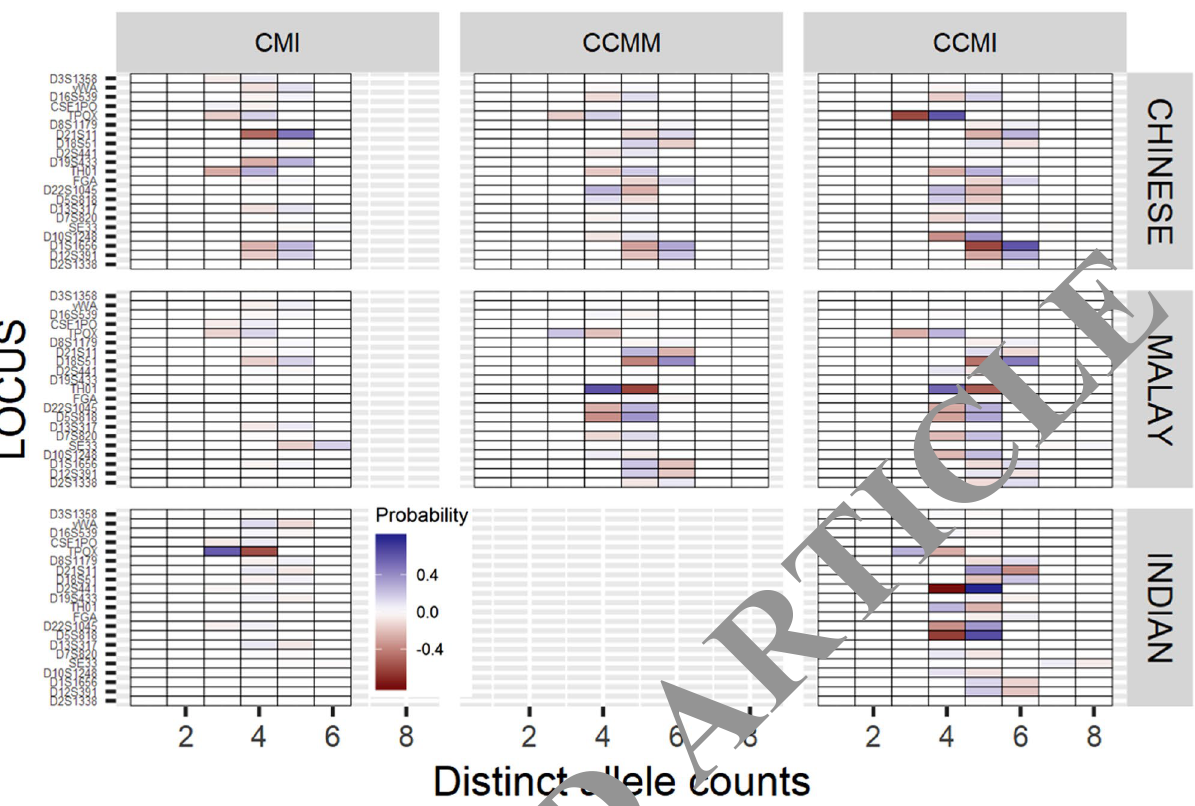
Figure 4. Heatmap of distinct allele counts, based on the differences between the probability obtained from a mixture DNA profile of mixed ethnic population (i.e. CMI, CCMM, CCMI) and that of an entirely same Chinese, Malay, or Indian (y-axis on the right) ethnic population. The differences in probability is calculated as mixed minus entirely same ethnic population mixture DNA profile. The combination of the ethnic populations for CMI, CCMM, and CCMI mixture DNA profiles are identical to that in Fig. 3.